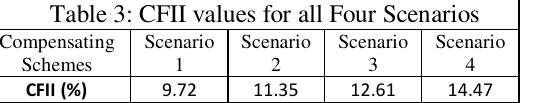
Table 3: CFII values for all Four